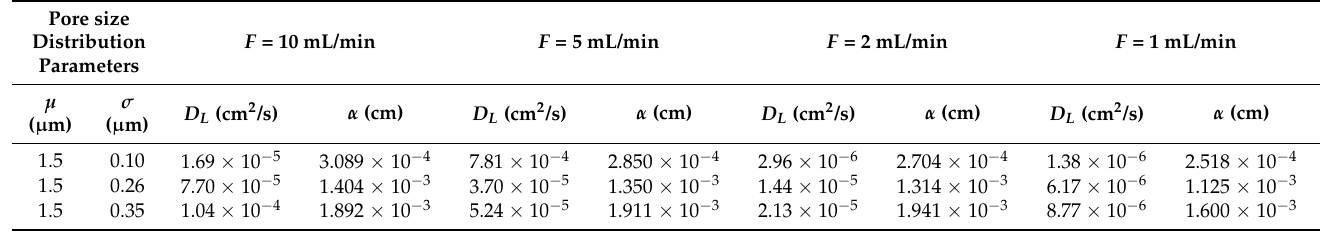
Table 6. Values of the dispersion and dispersivity coefficients with flowrate calculated with the polydispersed